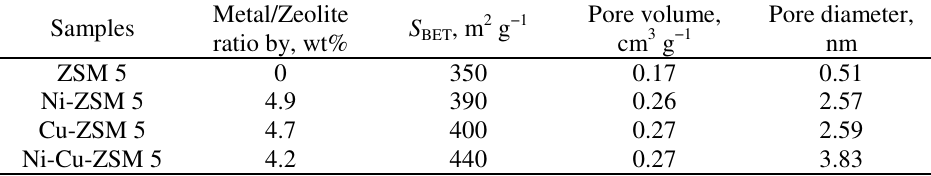
Table 1. Properties of the structure metal-ZSM-5 through the addition of different metals.